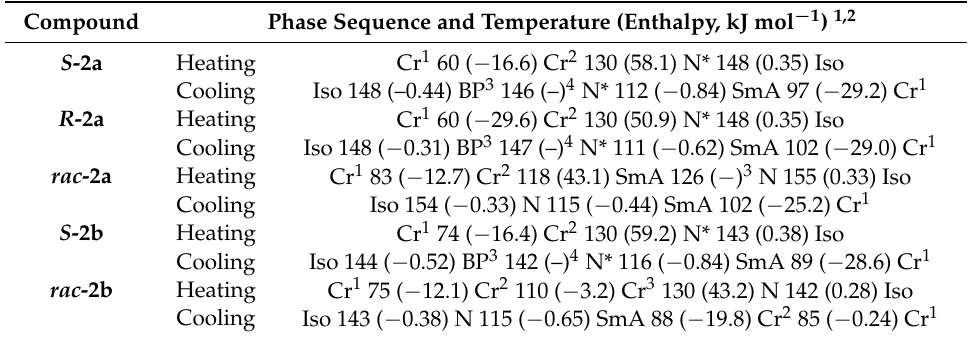
Table 1. Phase transition behavior of 2a and 2b in the second heating and cooling process.